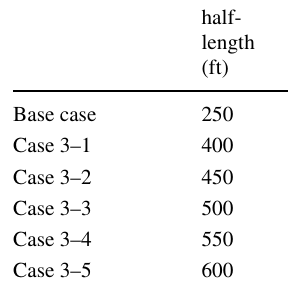
Table 10 Scenarios for fracture